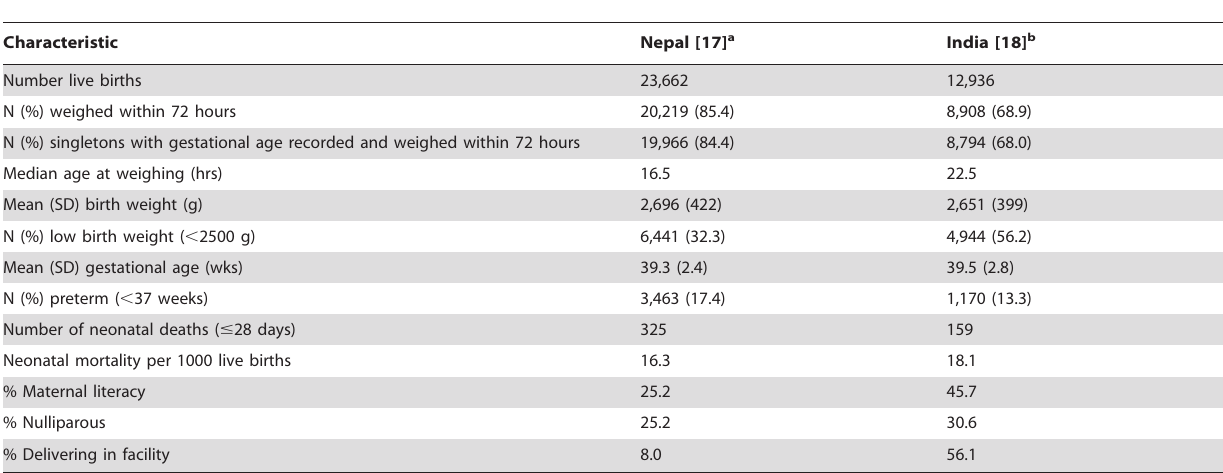
Table 1. Characteristics of Mothers and Infants in the Population-based Trials in Nepal and